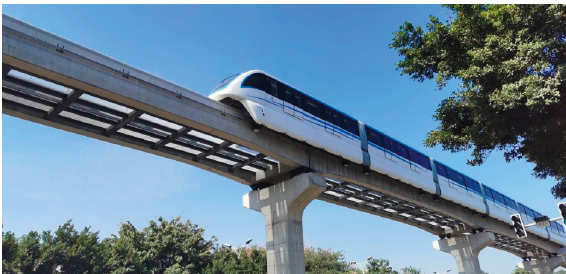
Figure 1: The transportation mode of straddle monorail is that the vehicle runs in the state of hugging the